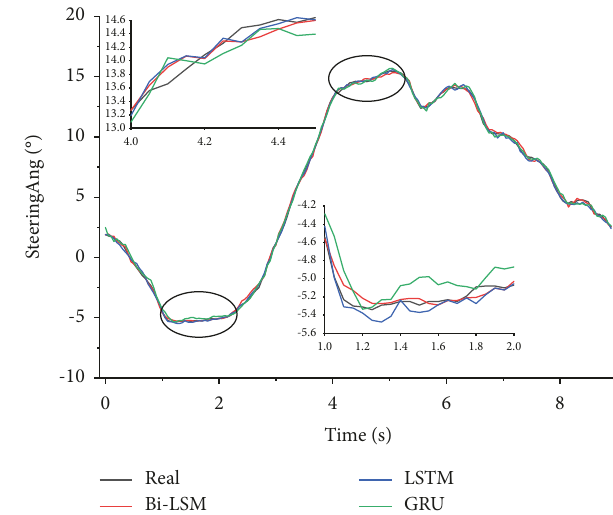
Figure 16: Comparison of prediction results based on LSTM, GRU and Bi-LSTM models.